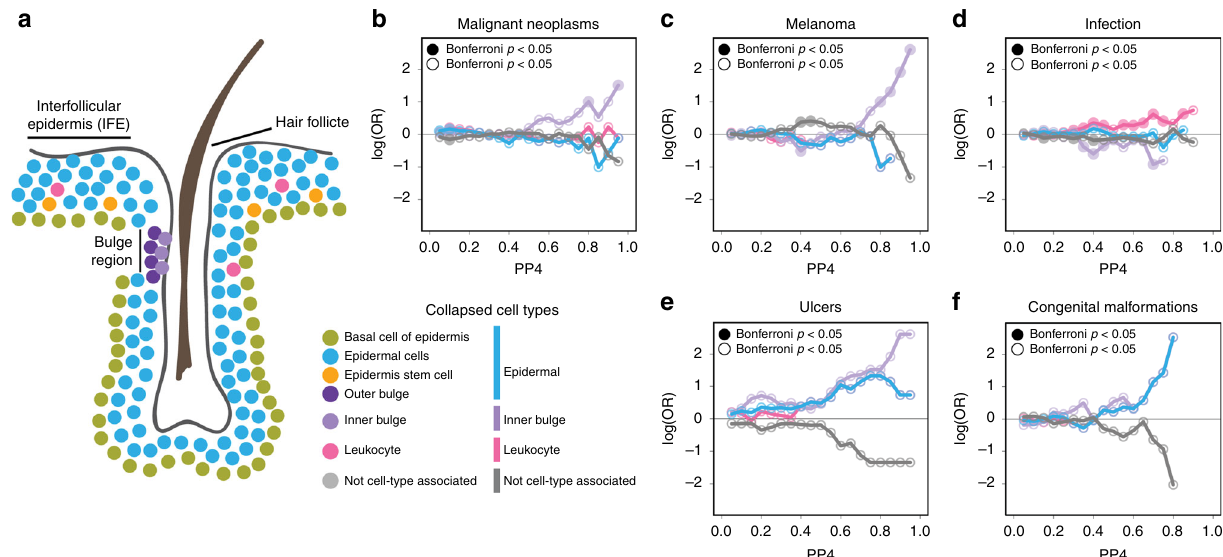
Fig. 6 Colocalization of cell-type-associated skin eQTLs with skin GWAS traits. a Cartoon describing the approximate organization of cell types identi fi ed in scRNA-seq from skin. Colors used for each cell type are used throughout fi gure and described in the adjacent legend. b – f Line plots showing the enrichment of cell-type-associated eQTLs in various GWAS traits: malignant neoplasms c , melanoma d , infection e , ulcers f , and congenital malformations g . Enrichment is plotted as the log(OR) ( y -axis) over all probabilities of the eQTL signal overlapping (0 = not overlapping – 1 = completely overlapping) with the GWAS signal ( x -axis). Lines are colored following color coding of each cell type from Fig.